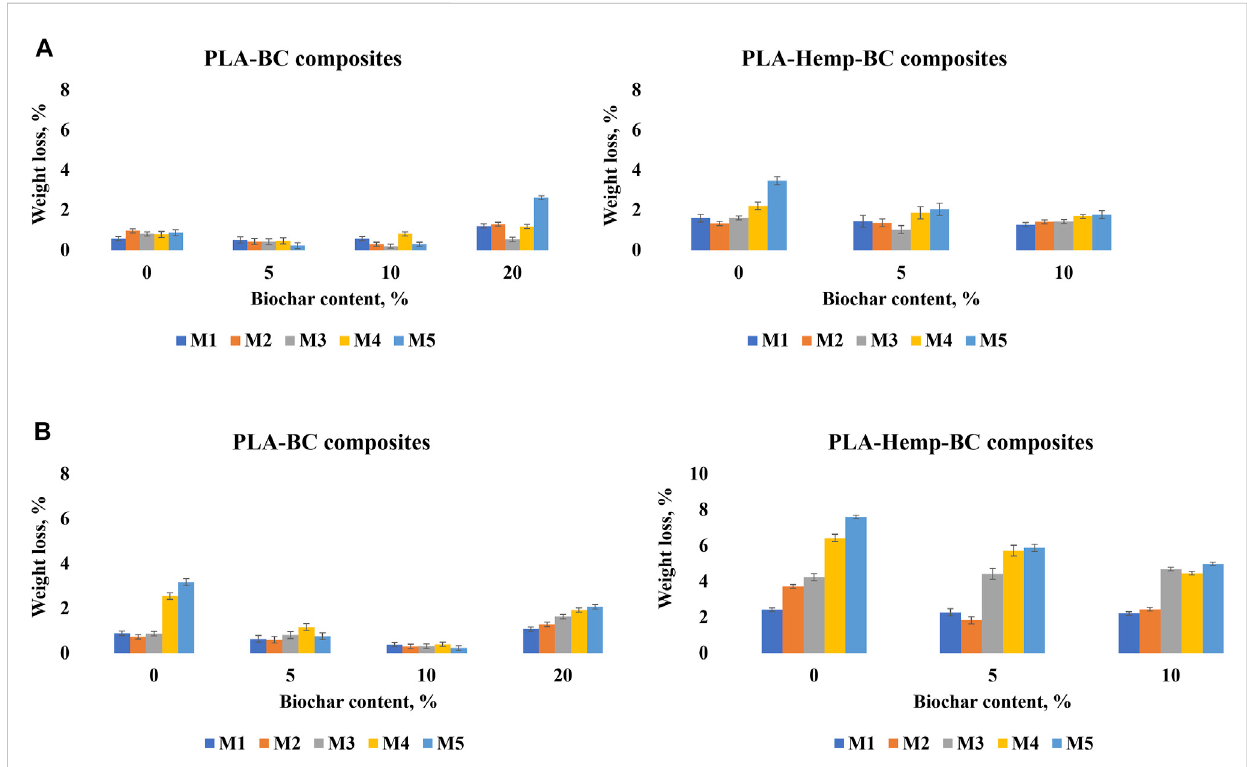
FIGURE 1 Weight loss results during exposure to (A) white and (B) brown rot